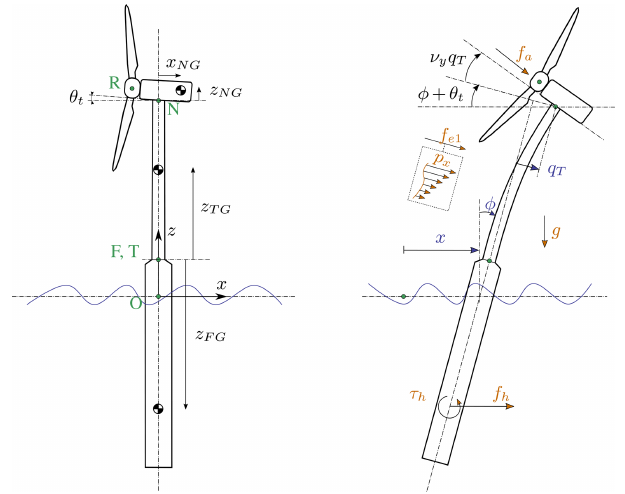
Figure 7. Model of a floating wind turbine using 3 degrees of free- dom. Points are indicated in green, degrees of freedom in blue, and loads in orange.